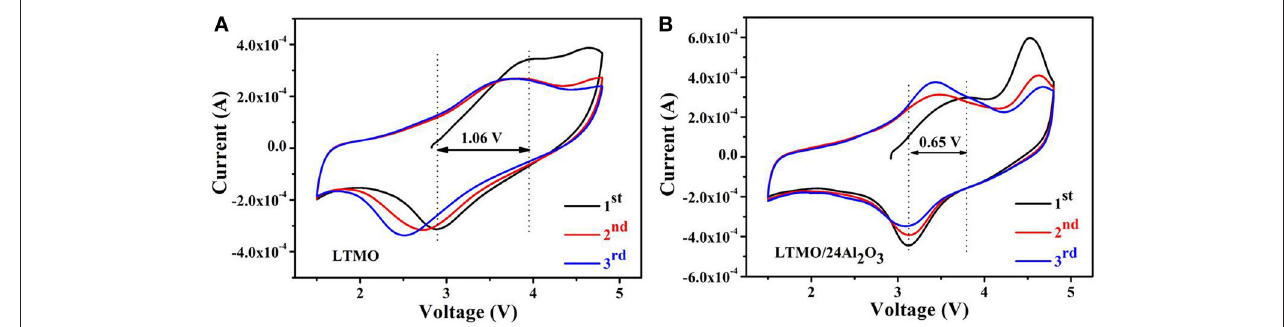
FIGURE 6 | Cyclic voltammetry of (A) LTMO and (B) LTMO/24Al 2 O 3 .